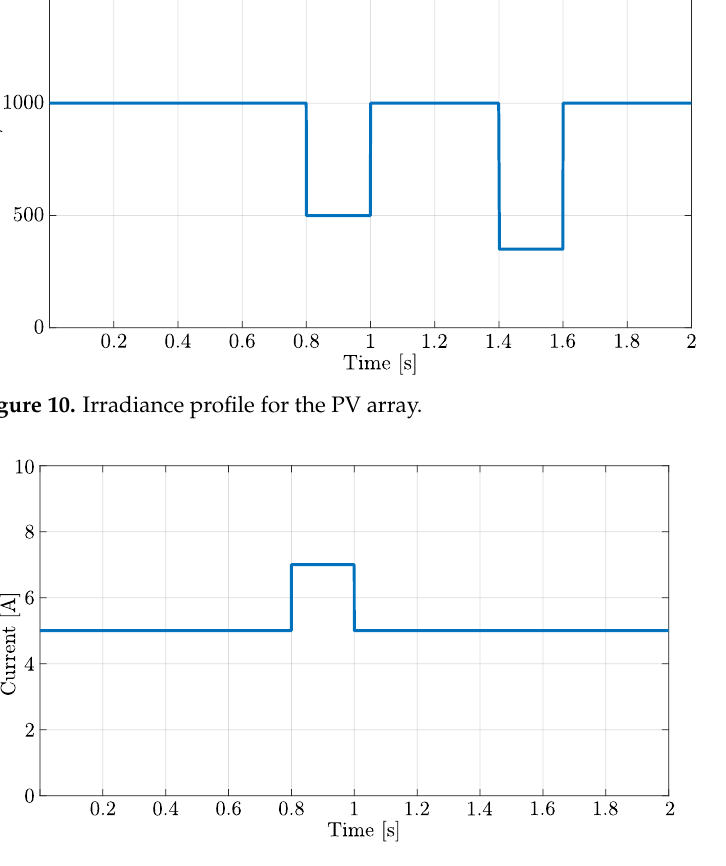
Figure 11. Current load